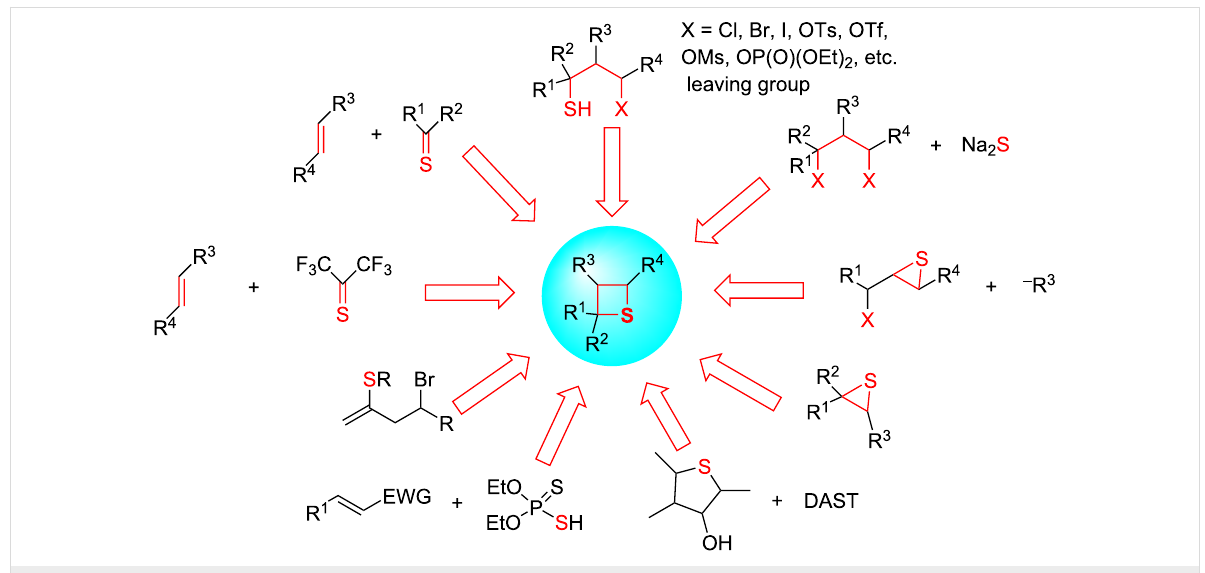
Figure 2: The diverse methods for the synthesis of thietanes.